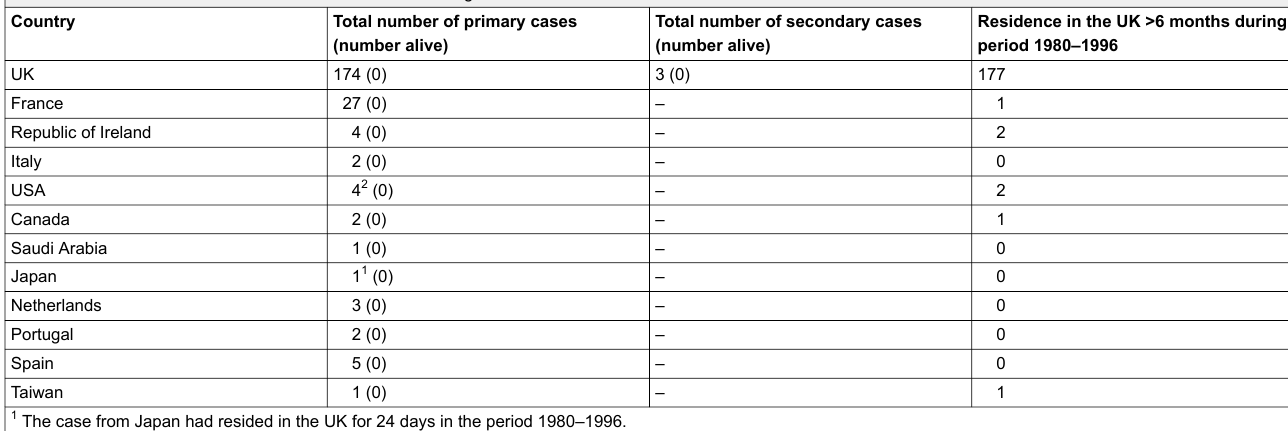
Table 1 : Variant Creutzfeldt-Jakob disease - current data: August 2015.